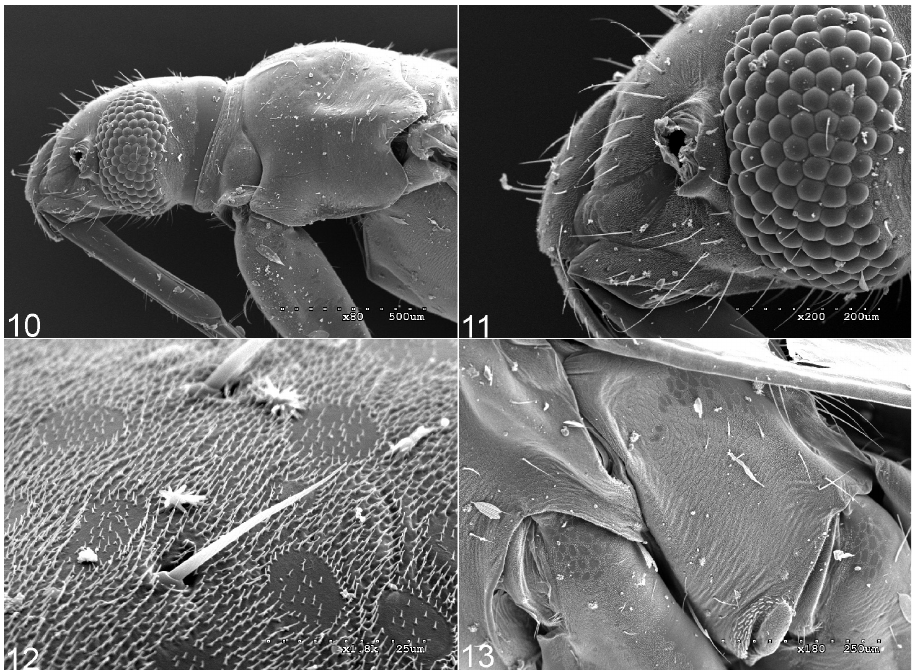
Fulvius constanti Gorczyca, 2004 Fulvius constanti Gorczyca, 2004: 154, figs 1–3; Gorczyca 2006: 41; Sadowska-Woda 2005: 21, 26, 27, 57, 93, 106, 170, 171, 172, tab. 19 figs 1–3; Sadowska-Woda et al. 2006: 619, 625, 633, 634, Figs 2, 21. Fulvius nigricornis : Carvalho and Lorenzato 1978: 136, figs 50–53, 88, (nec Poppius 1909). Diagnosis. Eyes contiguous with pronotal collar (Figure 3); antennal segment II dark brown with broad, yellow annulation apically (Figure 3); corium with pale patch over cuneus (Figure 3); clavus with pale, thin stripe along outer margin and small, yellow patch apically (Figure 3); male genitalia as in Gorczyca (2004: figs 1 –3). Remarks. Fulvius constanti is most similar to F. flavicornis , F. subnitens , F. thailan- dicus , and F. tumidipennis in having the eyes contiguous with the pronotal collar; the corium covered with dense setae, a pale patch over the cuneus; and the left paramere with an elongate apical process. It can be distinguished, however, by the absence of pale patches basally on the corium; the clavus with a thin, yellow stripe along its outer margin; and the shape of the male genitalia. Biology.